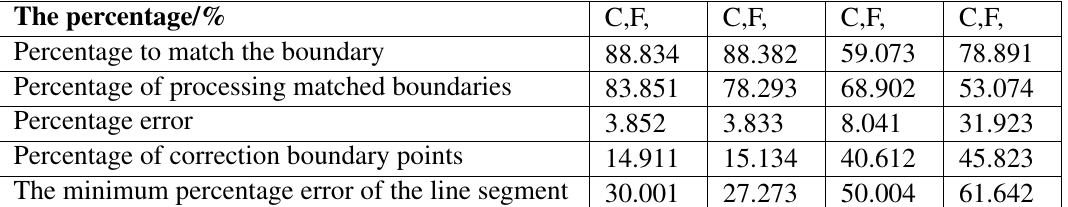
Table 2 Performance comparison of test images (cid:173) four graph phase difference functions The percentage/% C,F, C,F, C,F, C,F, Percentage to match the boundary